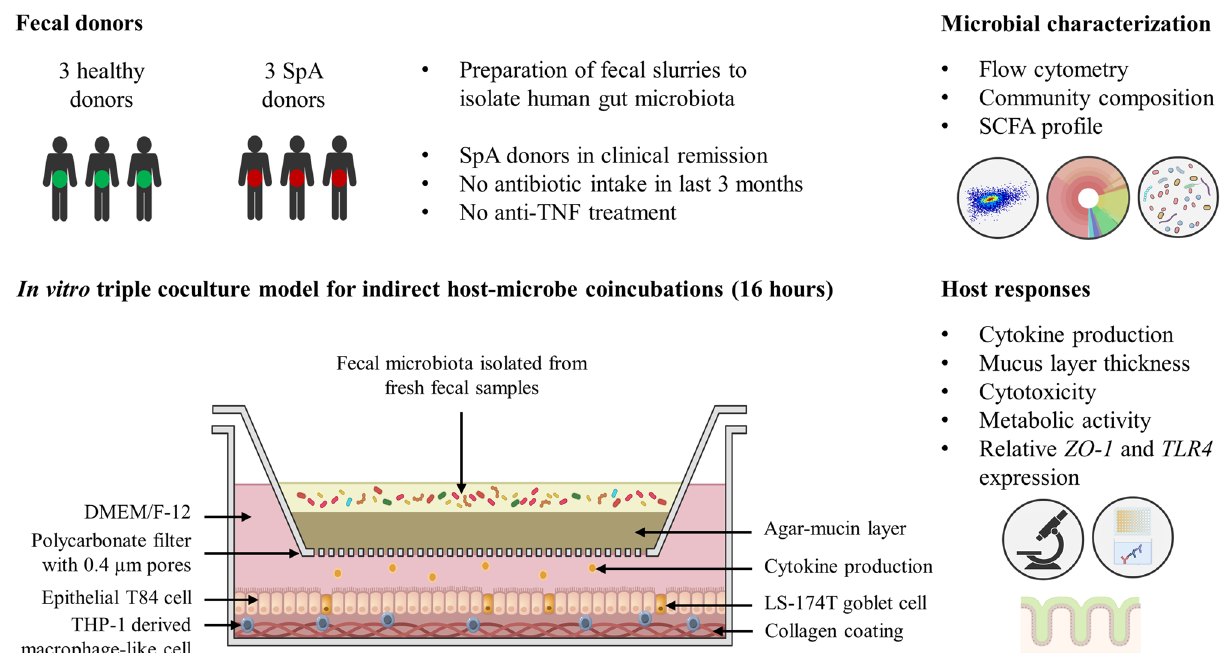
Figure 1. Schematic representation of the experimental approach. In vitro triple coculture figure was adapted from Beterams et al. 28 .